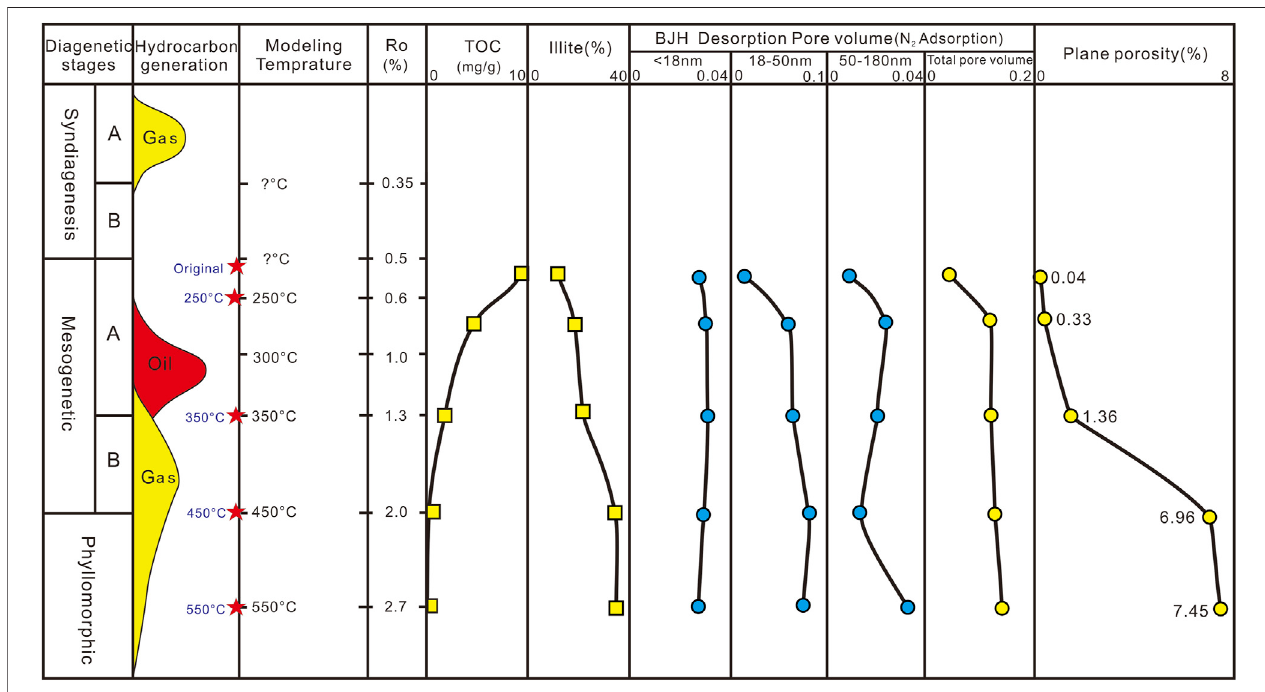
FIGURE 12 | Porosity evolution model of OMR shales from NJ